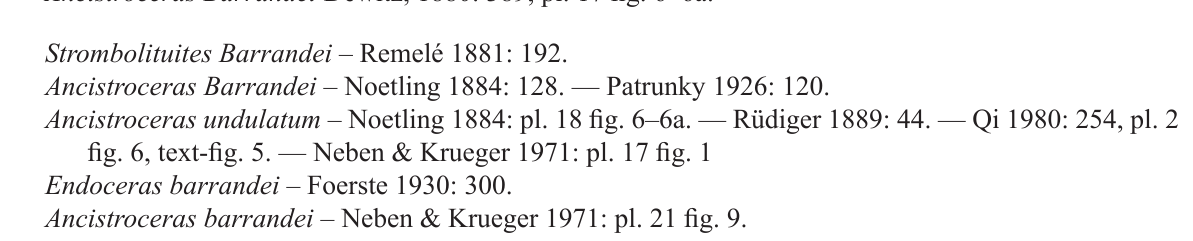
fig. 6, text-fig. 5. — Neben & Krueger 1971: pl. 17 fig. 1 Endoceras barrandei – Foerste 1930: 300.